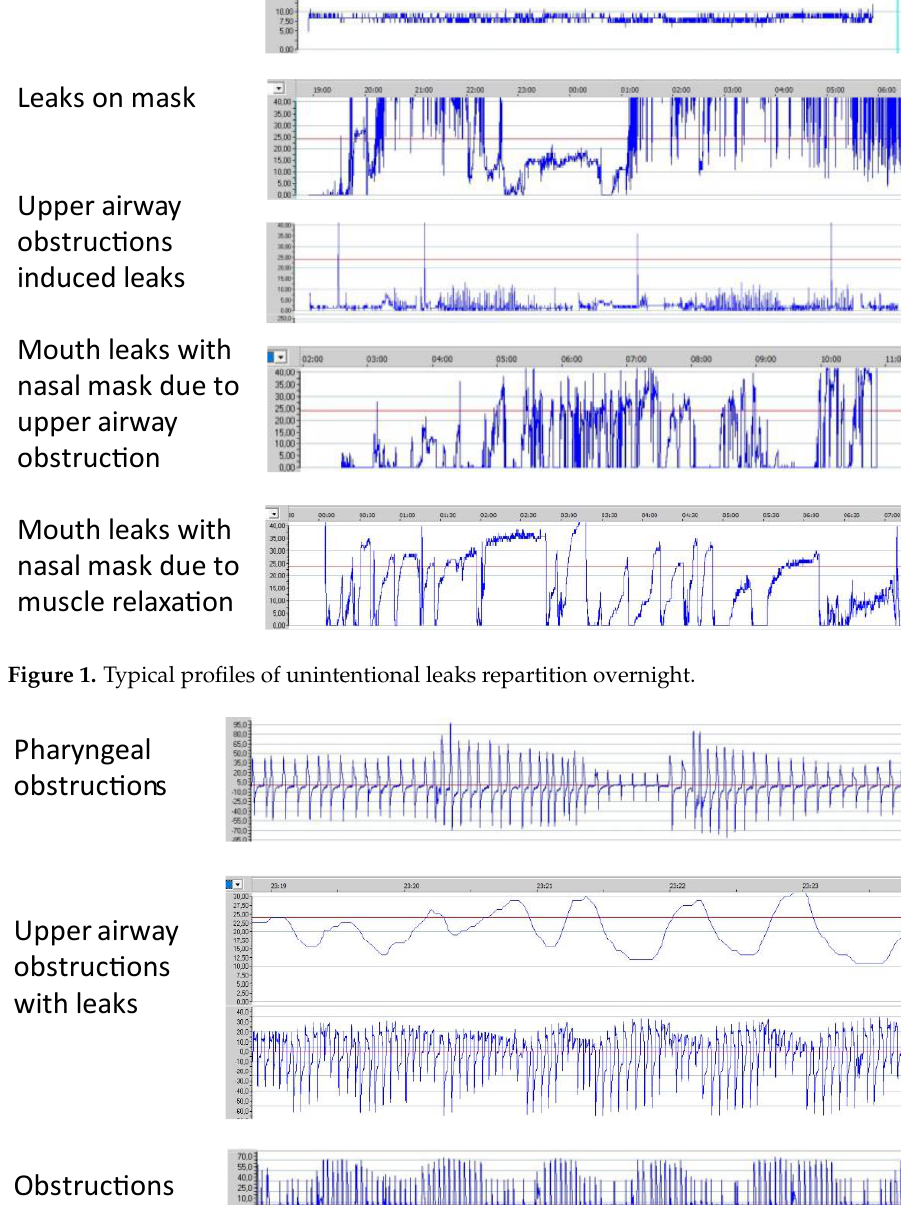
Figure 1. Typical profiles of unintentional leaks repartition overnight.